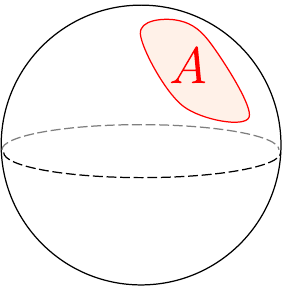
Figure 1 . General con(cid:12)guration of the 1 = 8-BPS Wilson loop, denoted by a red curve. The 1 = 8- BPS Wilson loop lives on S 2 and couples to a scalar as prescribed in (2.1) . The expectation value of such a loop depends only on the area A of the region inside the loop (the red-shaded region in the (cid:12)gure). Note that, although \the region inside/outside the loop" is not a well-de(cid:12)ned notion, such ambiguity does not a(cid:11)ect the expectation value since it is invariant under A ! 4 (cid:25) (cid:0) A , which exchanges the regions inside and outside the